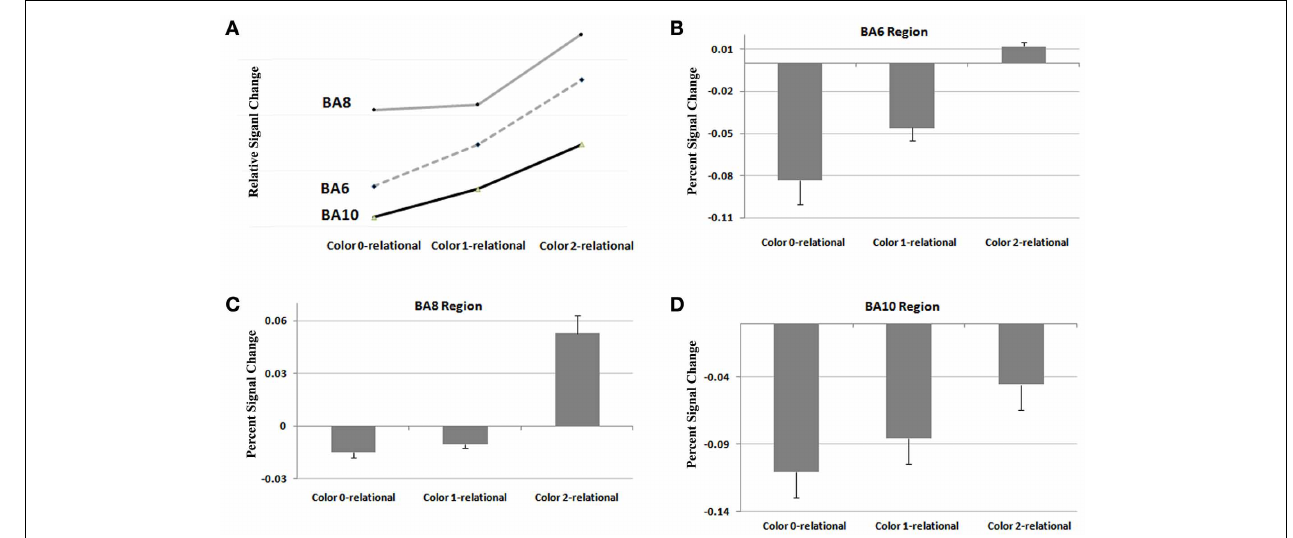
FIGURE 5 | Results from a functional ROI analysis of areas comprising the RLPFC for signal intensity at Color at 0, 1, and 2 levels of relational complexity. (A) Relative signal change in RLPFC across levels of complexity,